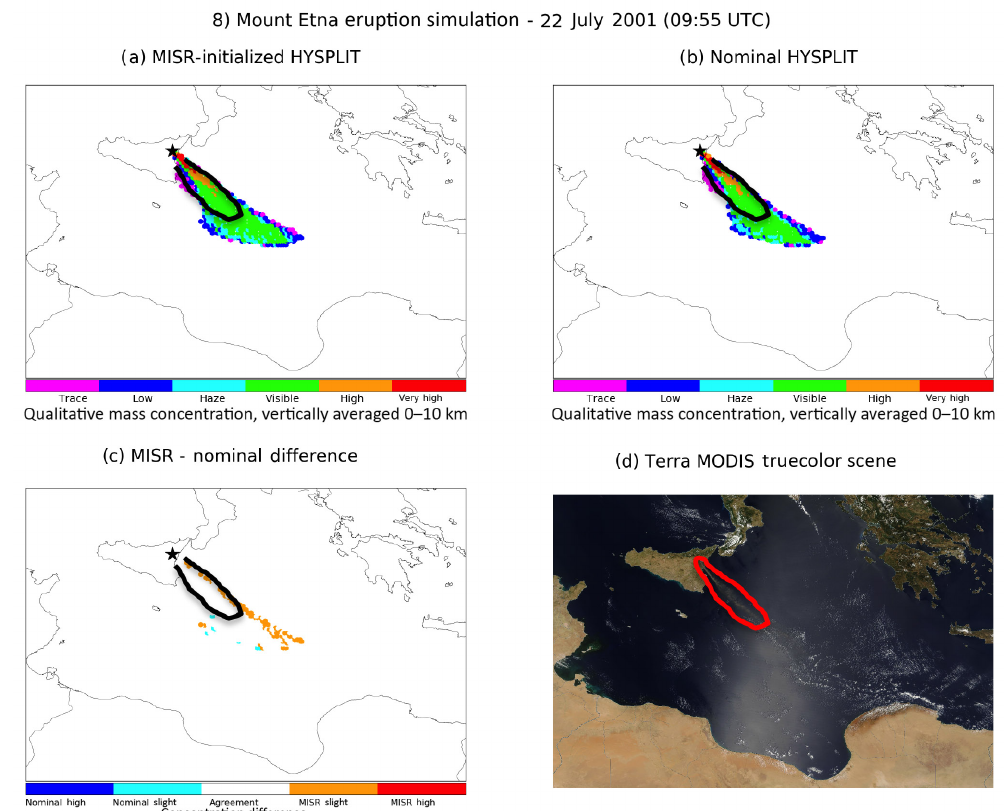
Figure 8. Same as Fig. 2, but for the Mount Etna volcanic eruption plume, on 22 July 2001. (a–b) Day 1 samplings of HYSPLIT 96h simulations that began on 22 July 2001, (c) and Day 1 difference plot. (d) MODIS true-color image acquired on 22 July